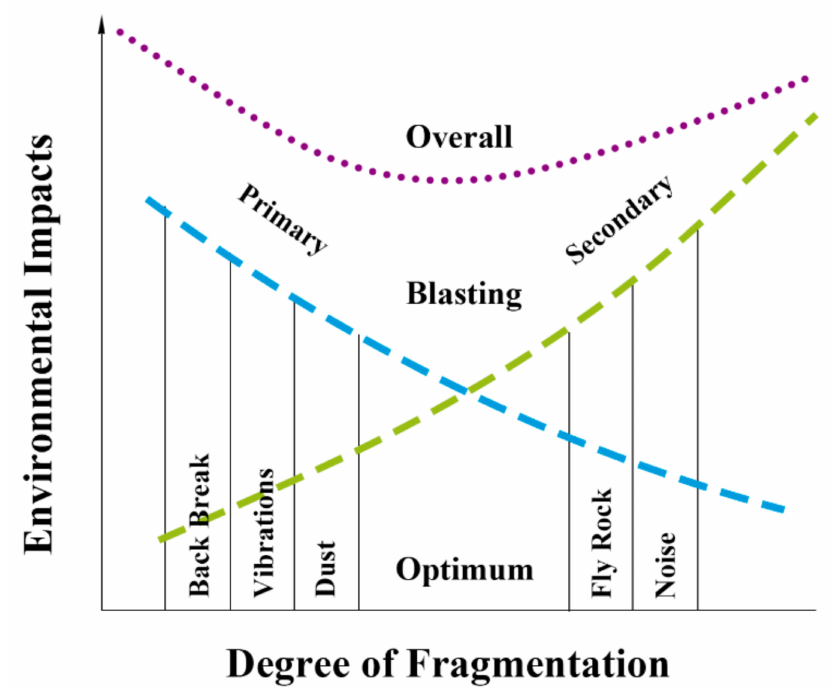
Figure 1. Negative environmental impacts accompany the primary and secondary rock breakage [8].